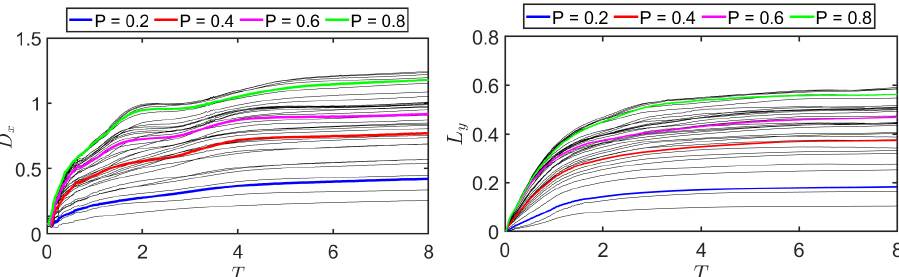
Figure 8. Time evolution of the scaled horizontal coordinate of the frontal point D x ( T ) and the scaled vertical coordinate of the deepest point L y ( T ) .